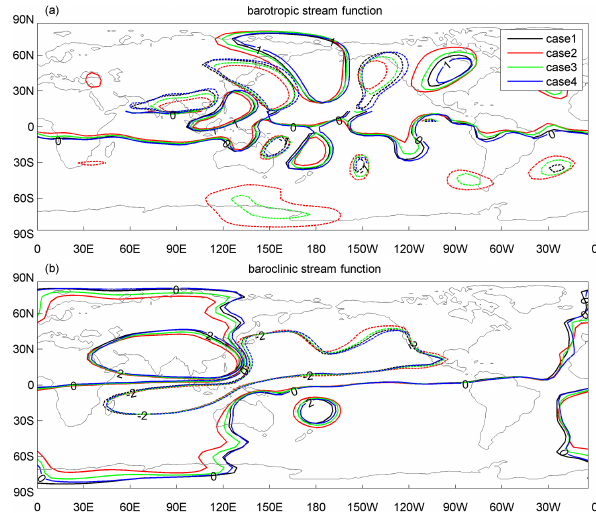
Figure 4. Barotropic (a) and baroclinic (b) stream function anoma- lies for Case 1. The contour interval is 1 × 10 6 m 2 s − 1 .